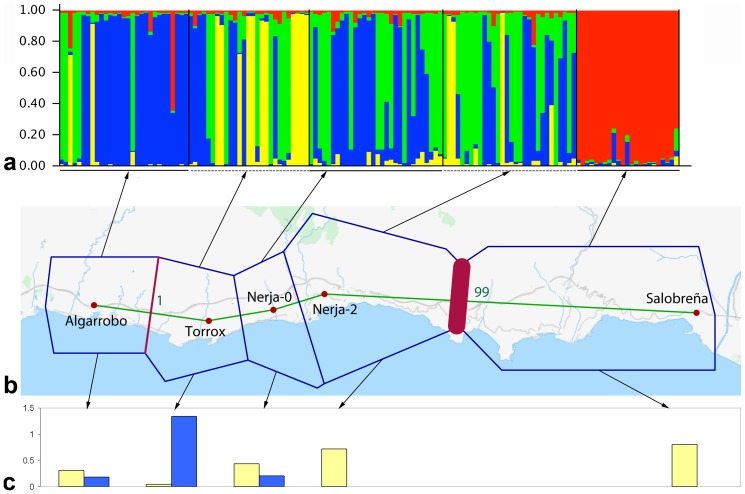
Genetic and geographical structure of the E. plorans populations analyzed.a) Ancestry of each individual from the four genetic groups (K = 4), using all 94 fragments of different size observed for the six ISSR markers analyzed, yielded by the Structure software. Each vertical bar represents one of the 139 individuals analyzed. Note that all individuals from Salobreña were assigned to group 4 (red), most individuals from Algarrobo were assigned to group 1 (blue) whereas individuals from Torrox and Nerja showed a mixture of groups 1 (blue), 2 (green) and 3 (yellow). Bar length is proportional to the ancestry values inferred in each group for each individual. b) Geographical location of the five populations used for the ISSR analysis, Delaunay triangulation and the significant barrier (red) between Nerja-2 and Salobreña populations, detected by the Barrier software. c) Mean number of B chromosomes per individual for the B2 (yellow) and B24 (blue) variants, found in 2006, i.e. the same year in which the ISSR markers were analyzed.